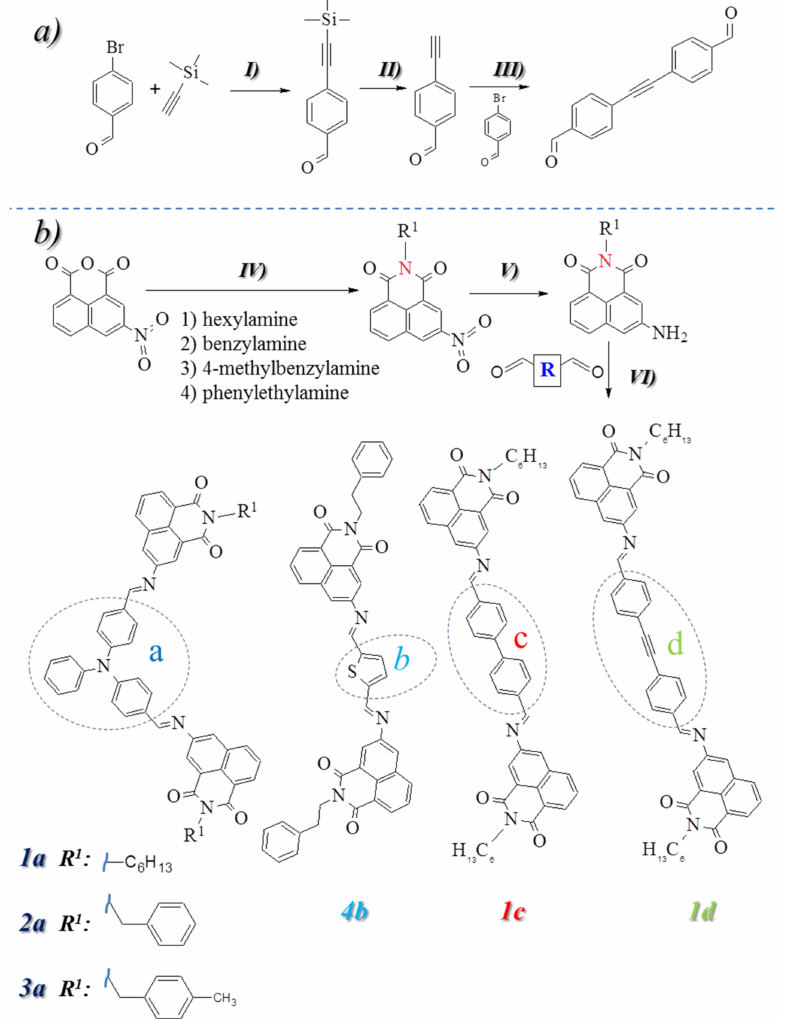
Figure 1. ( a ) Synthesis of dialdehyde: (I) 4-bromobenzaldehyde, trimethylsilylacetylene, Et 3 N, PdCl 2 , PPh 3 ,Cu, 65 ◦ C, 3 h, (II) MeOH, K 2 CO 3 , 2 h, rt., (III) 4-bromobenzaldehyde,